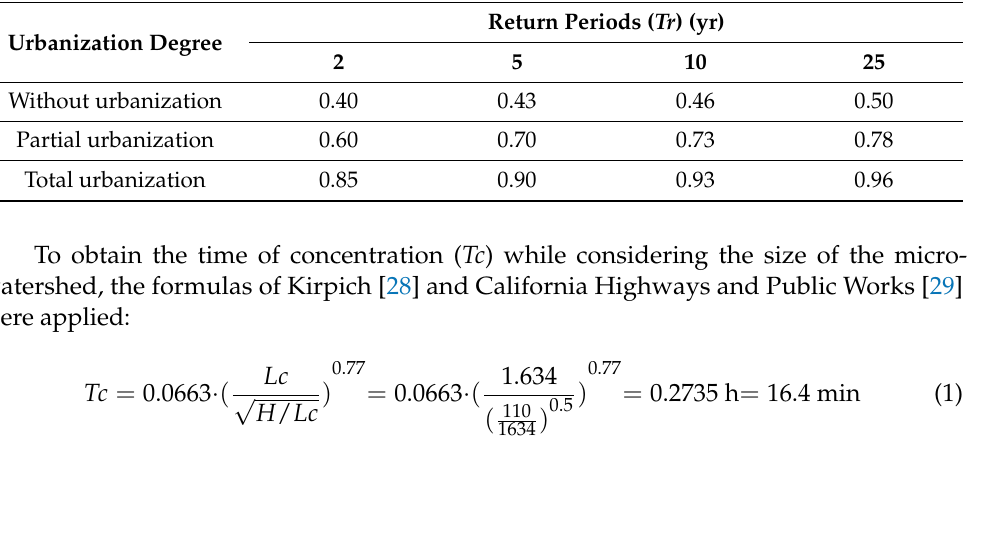
Table 1. Runoff coefficients of the micro-watershed area of 0.014 km 2 , according to the previous study and urbanization